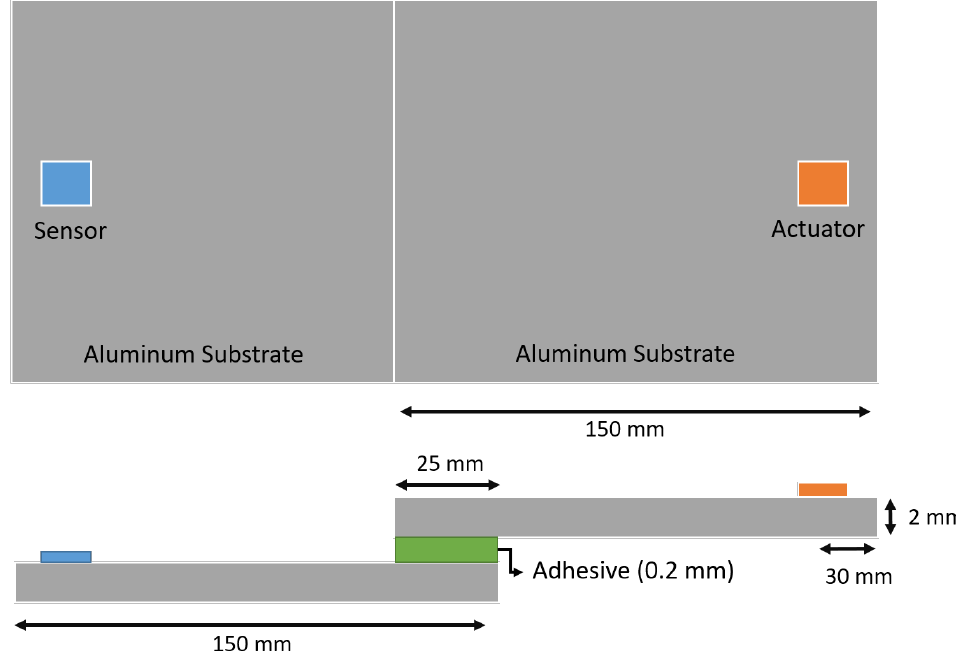
Figure 6. Top and side view of the adhesive joint simulation setup with the position of the sensor and actuator and the overall dimensions of each